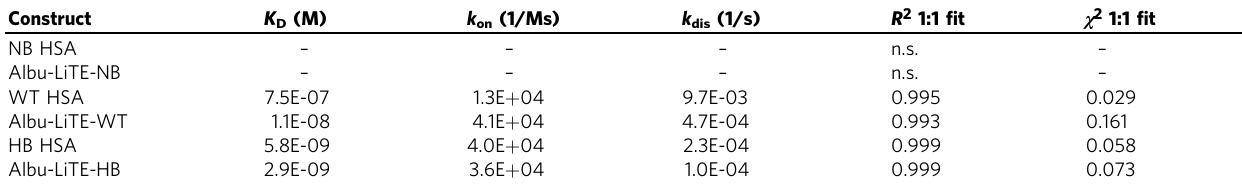
Measuredbindingaf fi nities( K D , k on and k dis )forHSAandAlbu-LiTEconstructswith χ 2 and R 2 forthe fi tsareshownforeachconstruct.Bindingaf fi nitiescouldnotbedeterminedfortheNullbinding(NB) HSA and Albu-LiTE-NB construct due to low binding responses and lack of fi t in a 1:1 binding model, n.s. non-signi fi fi t to a 1:1 binding model, comparable to the unfused WT and HB HSA variant (Fig. 2a – d). The NB construct resulted in a weak a weak unspeci fi c binding to FcRn at low pH which was also observed for the Albu-LiTE-NB; however, neither could be fi tted